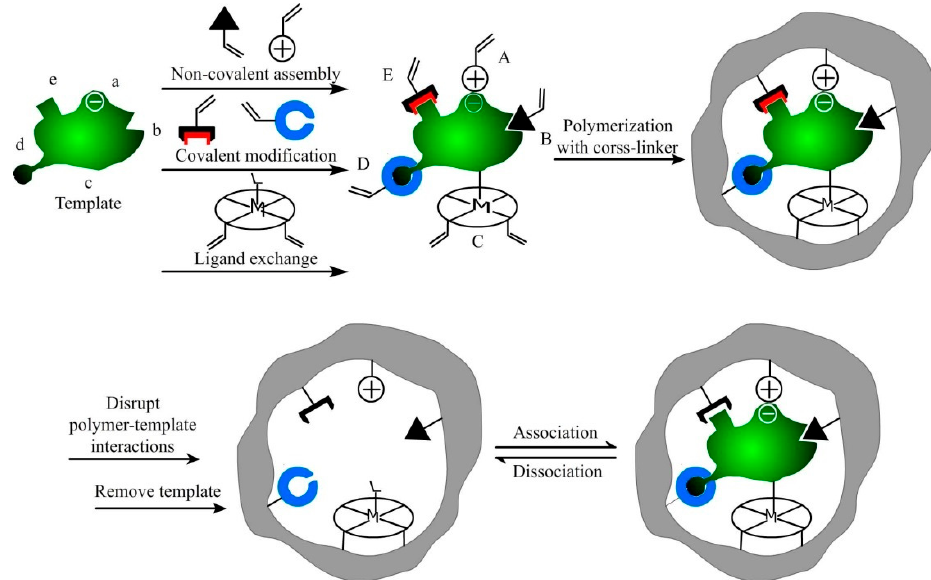
Figure 1. Highly schematic representation of the molecular imprinting process. Reprinted with permission from Reference 3. Copyright 2014, Wiley.